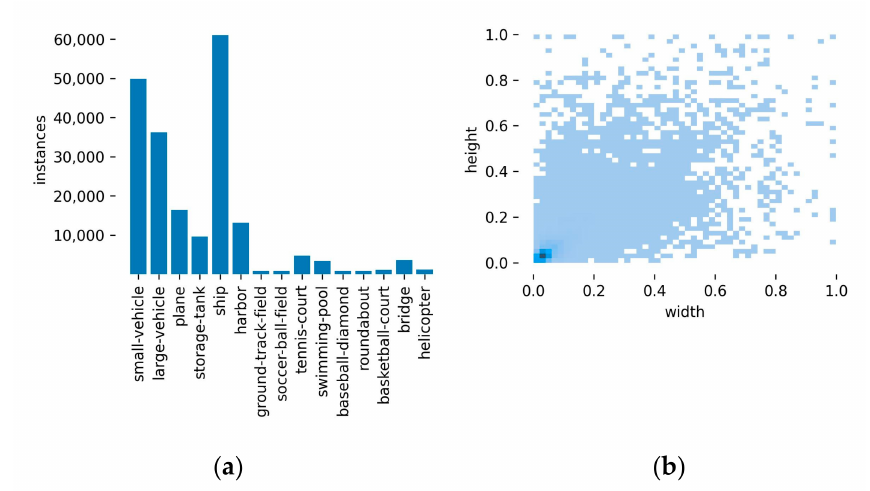
Figure 9. ( a ) The distribution of the classes of the labels; ( b ) heat map of the